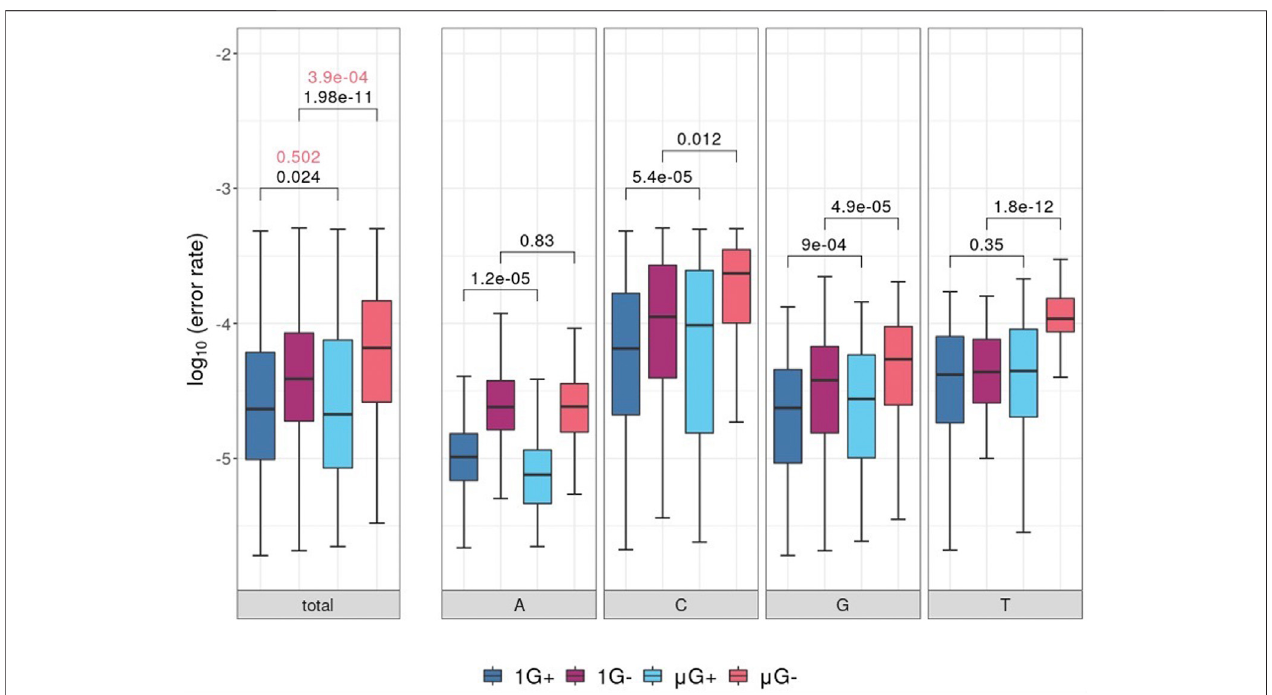
FIGURE 2 | Boxplots of locus-scale polymerase error rate distributions, with different samples showing microgravity ( μ G) or earth-like gravity (1 G) with + and – referring tothepresence orabsenceofexonucleaseactivity intheKlenow fragmentpolymerase,respectively. Signi fi cance values ofstatistical comparisons, which were calculated by Wilcoxon signed-rank tests were plotted in black, while those made using Mann-Whitney U tests were plotted in red. (A) Boxplots for each test condition. (B) Boxplot of polymerase error rate distributions for each test condition, separated by template nucleotide either adenine (A), cytosine (C), guanine (G) or thymine (T) listed below the clustered